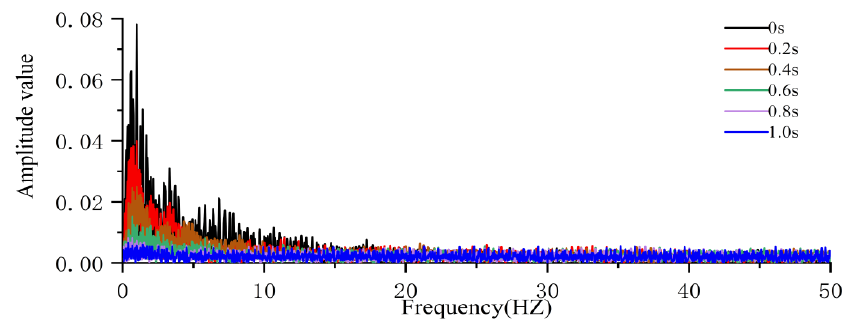
Figure 11. Swashplate inclination variation frequency domain curve for 555 s–590 s.